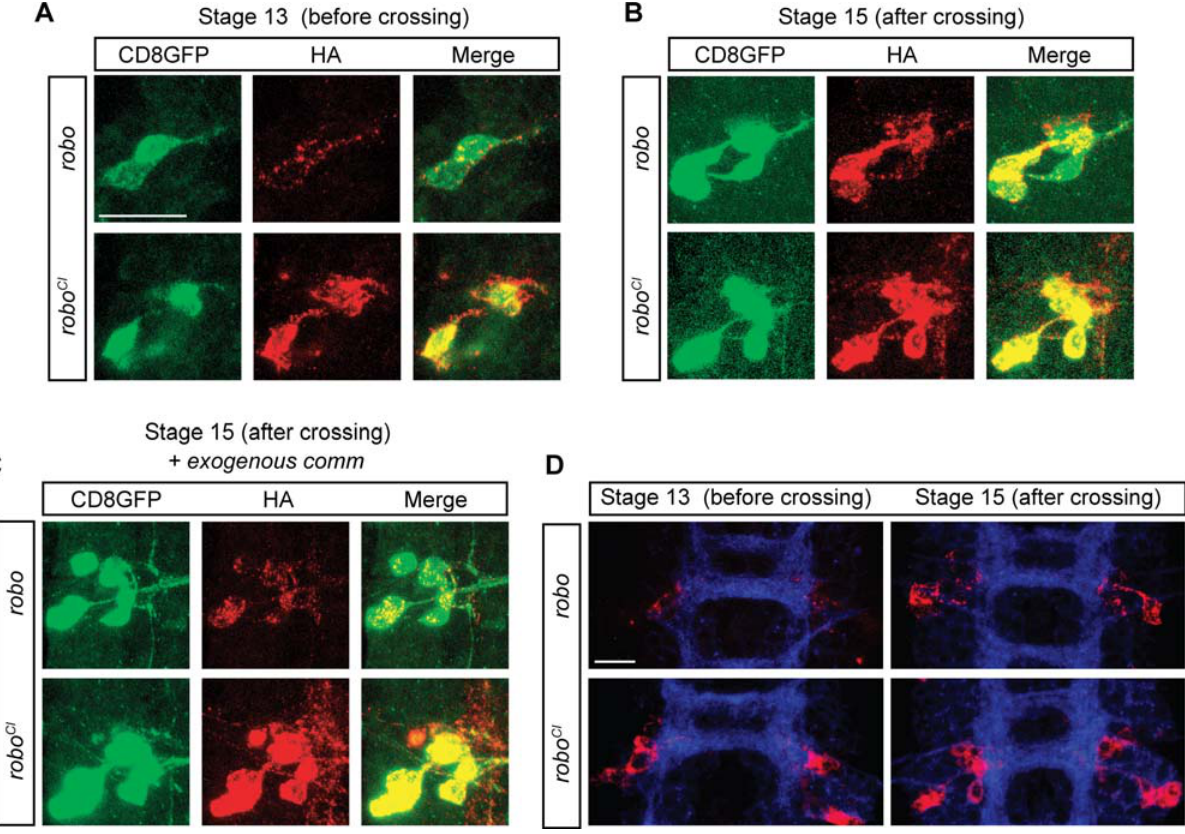
Figure 4. Robo SD is insensitive to Comm sorting in vivo. (A–B) Confocal images of single cells expressing the fluorescent marker CD8GFP (green) and an HA-tagged version of either Robo or Robo SD (red). Panel (A) shows the soma of poxn-GAL4 expressing cells at stage 13 of embryonic development, namely while their growth cone is crossing the midline; panel (B) shows analogous cells at stage 15, after the crossing is complete. Notice that while there is no difference between Robo and Robo SD localization at stage 15 (B), a clear difference is observable at stage 13 (A). (C) Same experiment as in (B) but with ectopic expression of a uas-Comm transgene. (D) Lower magnification images of one segment of the CNS of UAS- HA-Robo (upper two) and UAS-HA-Robo SD (lower two) expressing embryos, before crossing (leftmost two) and after crossing (rightmost two). Images in panels A–C are acquired using 100 6 magnification; images in panel D are acquired using 63 6 magnification. White size-bar indicates 10 m m.